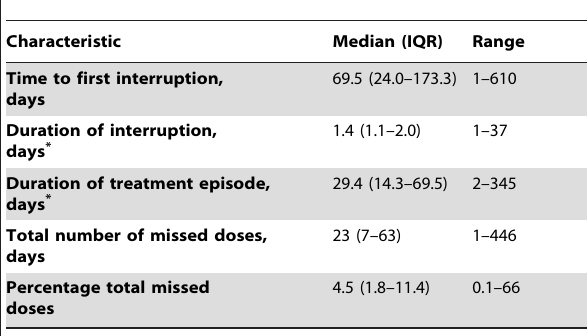
Table 2. Treatment interruption characteristics of MDR TB patients that missed at least one dose during the course of treatment